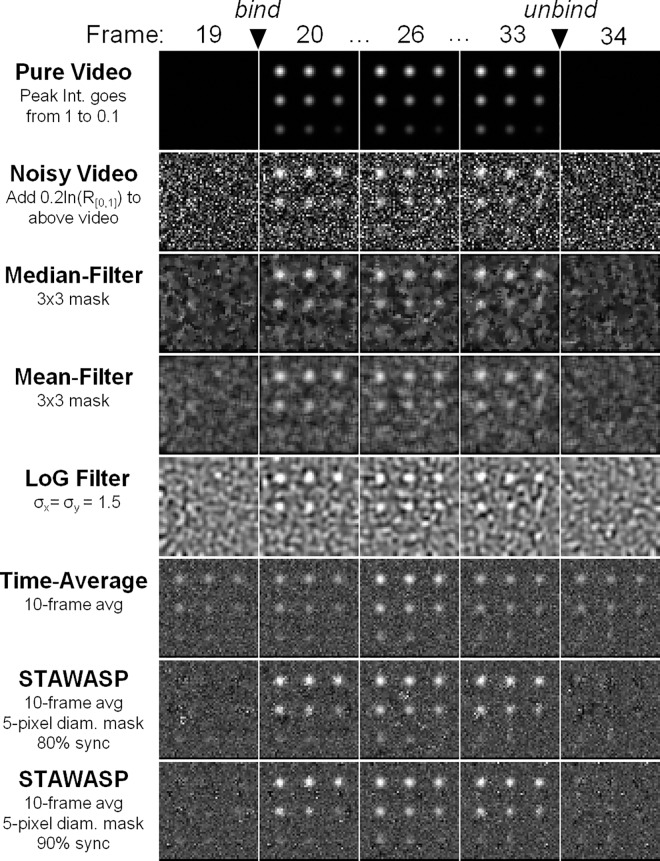
Testing various image restorations on a simulated movie.A simulated movie with noise was generated to compare image restoration performance (see Supporting Materials 1.3 for simulation details). The pure video shows particles with varying intensities appearing at frame 20 and disappearing after frame 33. Noise is added according to the function N = -0.2ln(R), where R is a uniform random number from 0 to 1. The SNRs of the 9 particles, from top left to bottom right are as follows: 5.0, 4.4, 3.9, 3.3, 2.8, 2.2, 1.6, 1.1, 0.5. The LoG (Laplacian of Gaussian) spatial filtering method is described by others [34, 63].